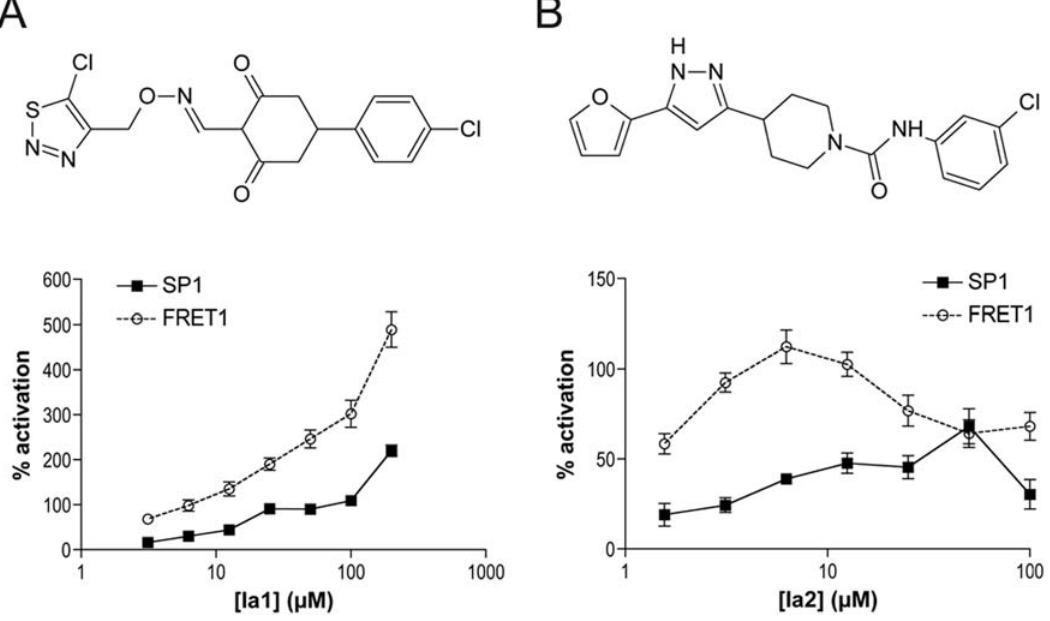
Figure 2. Small-molecule activators of IDE discovered through compound screening. A , B , Structures of Ia1 ( A ) and Ia2 ( B ) and dose- dependent effects on the IDE-mediated hydrolysis of SP1 and FRET1. Data are mean 6 SEM for 4 to 5 independent experiments normalized to control wells containing no ATP. Data for all doses showing $ 30% activation are statistically different from DMSO controls ( P , 0.05).